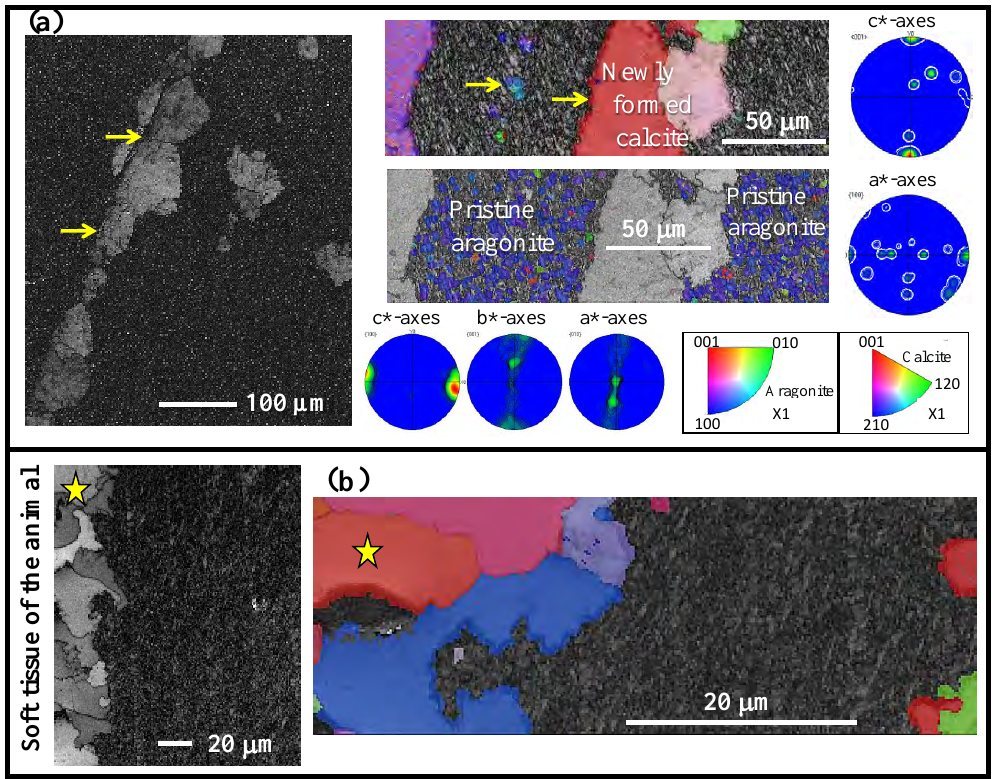
Figure 11. EBSD band contrast (in grey), crystal orientation (colour-coded for orientation) maps, and corresponding pole figures of altered Arctica islandica shells at 175 ◦ C in artificial meteoric (a) and burial (b) solution. Clearly visible is the initial formation of calcite at the location of former growth lines (yellow arrows in a ) and the growth of large calcite crystals (yellow stars in b ) that formed at the shell portion that is in direct contact with the alteration solution. Note that some pristine aragonite in the dense shell portion is still